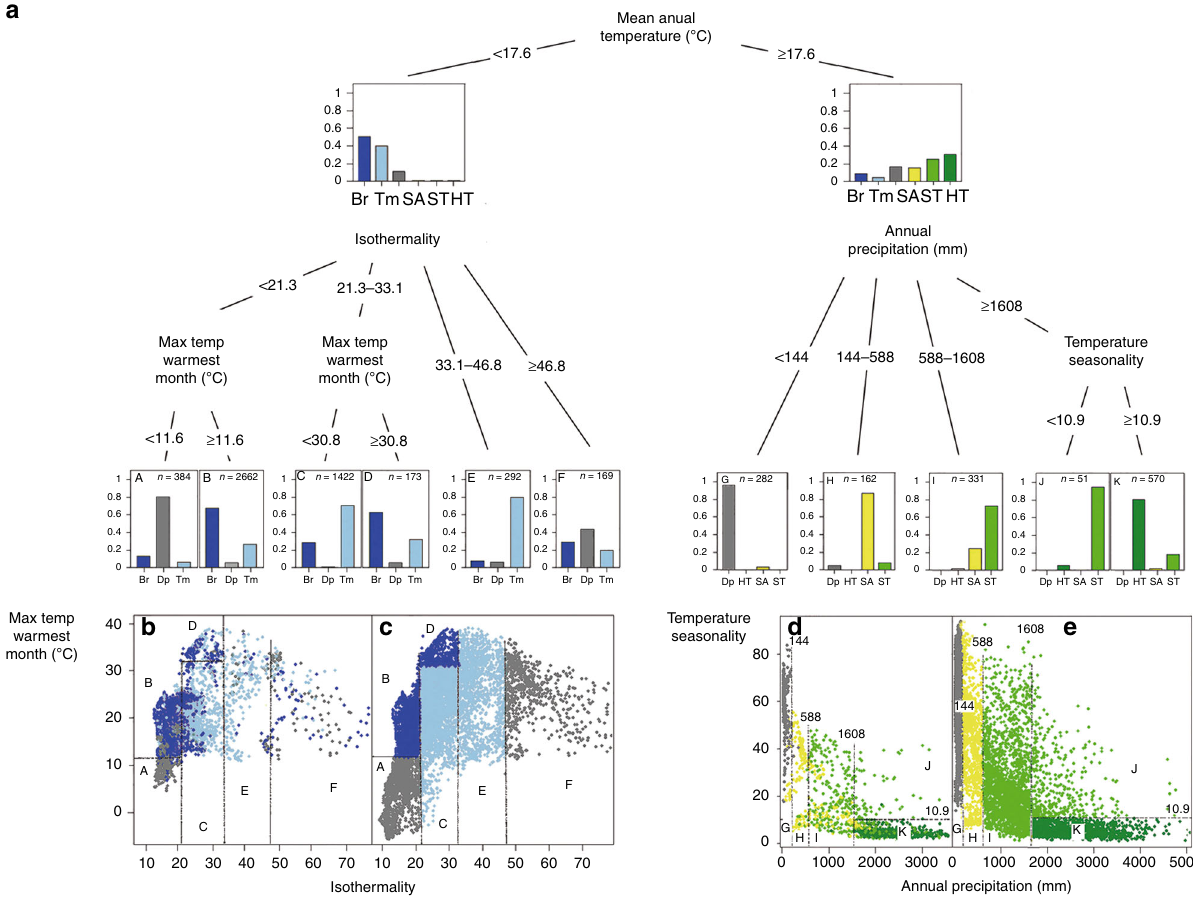
Fig. 3 Relationship between climatic predictors and mammal trophic structures. a Tree model relating climate predictors and trophic structures and splitting them into a cold (left) and warm (right) branch. b Plot of observed trophic structures against the climate space de fi ned by the two variables best explaining the cold branch (Mean annual temperature < 17.6 °C). c The same as b but using predicted rather than observed trophic structures. d The same as b, but in the space de fi ned by the two variables best explaining the warm branch (mean annual temperature ≥ 17.6 °C). e The same as d , but using predicted rather than observed trophic structures. Dots in panels b , c , d , and e are cells on the world map. Capital letters in panels b, c, d, and e correspond to the fi nal groups in panel a. Br Boreal, Tm Temperate, SA Semi-arid, ST Seasonal tropical, HT Humid tropical, Dp Depauperate. Isothermality = Mean diurnal range temperature/temperature annual range, Temperature Seasonality = The amount of temperature variation over a given period based on the standard deviation of monthly temperature